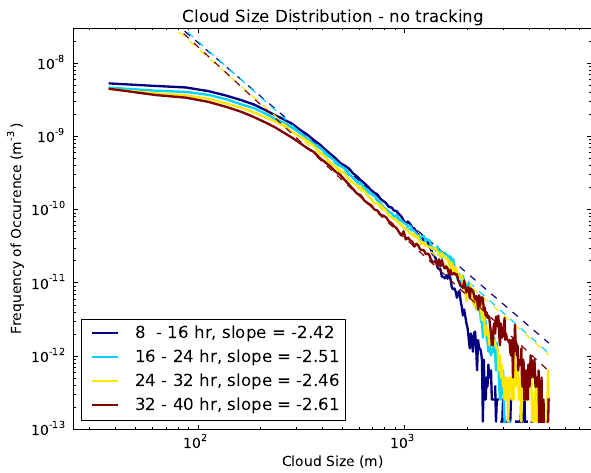
Fig. 7. Cloud size distribution after tracking. Solid lines are the averages over 8 h intervals, dashed lines are the best power law fit to the data between 400 and 1000m, with a respective slope given in the legend.